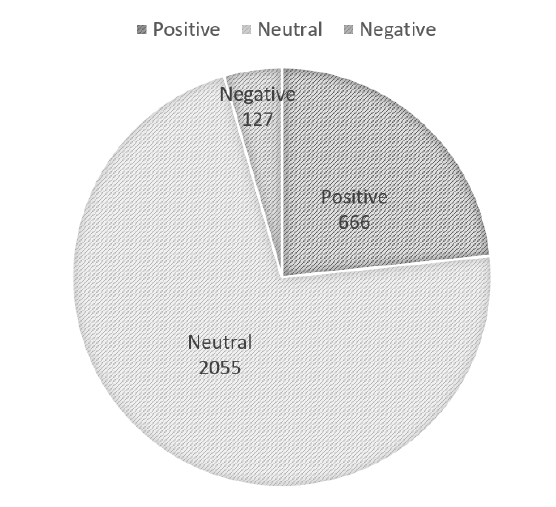
Fig. 2. Sentiment